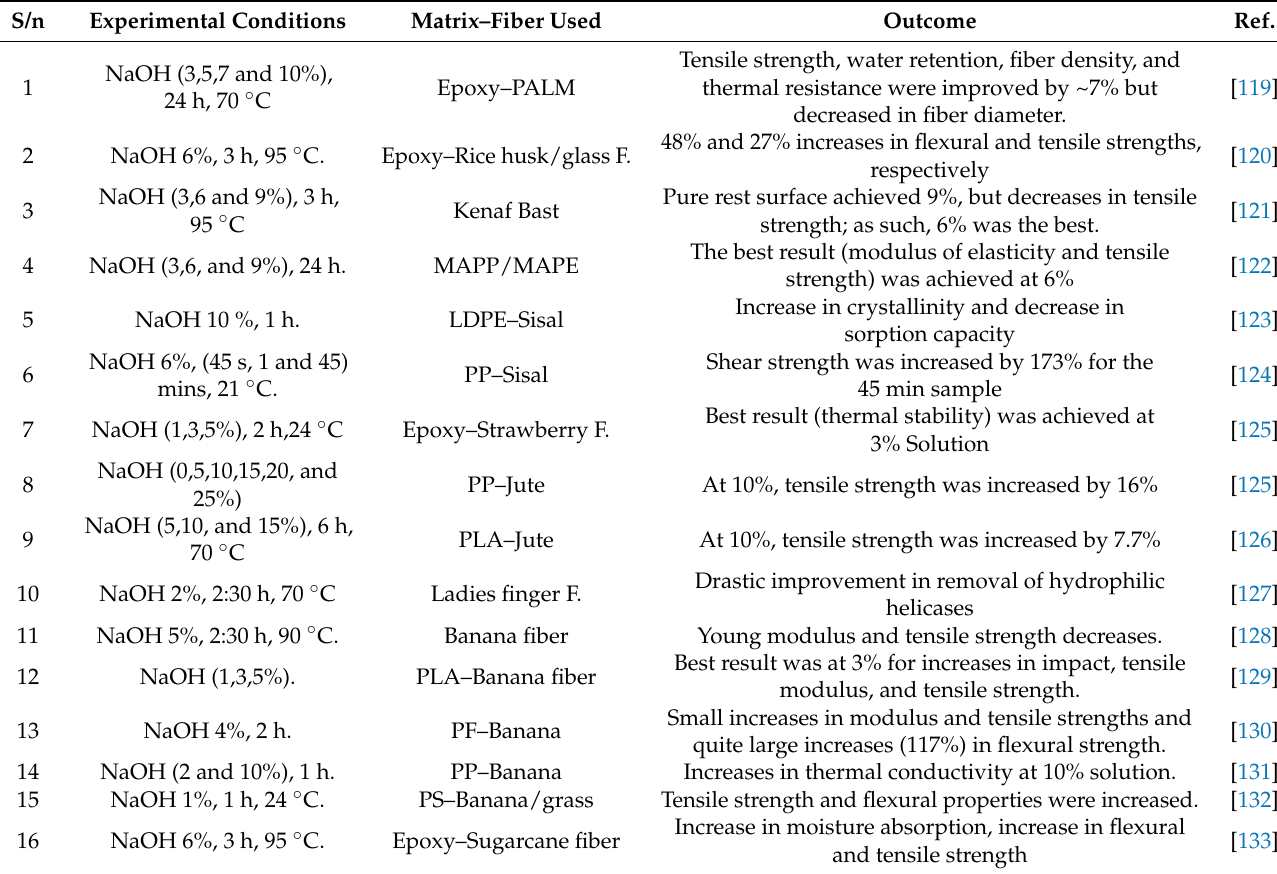
Table 4. Effect of sodium hydroxide on natural